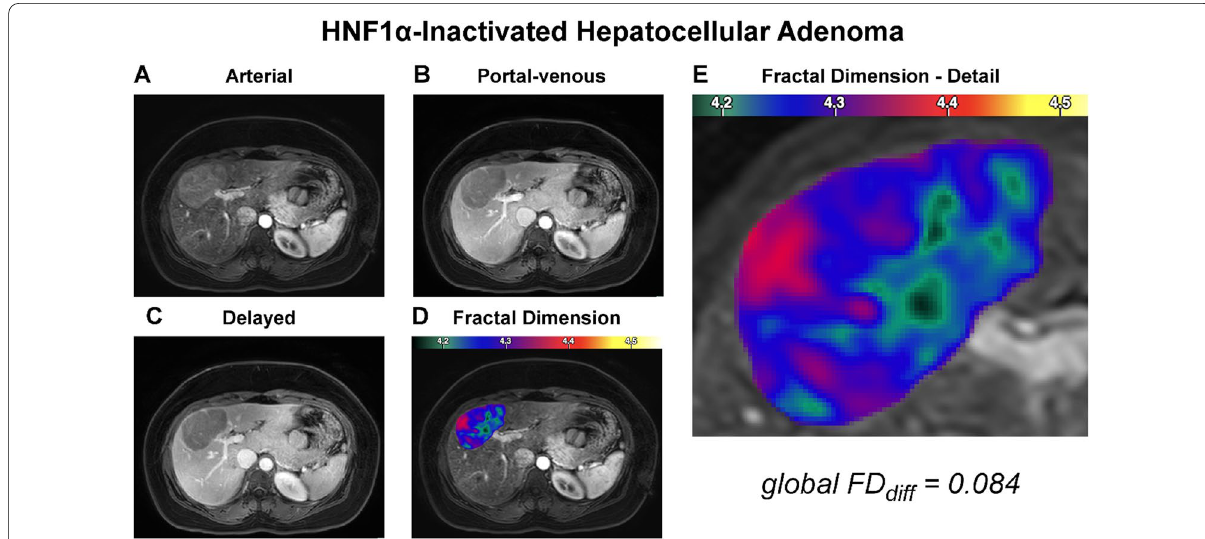
Fig. 2 Representative case of hepatocyte nuclear factor (HNF)-1α-inactivated hepatocellular adenoma. Dynamic contrast-enhanced MR images of the arterial ( A ), portal venous ( B ), and delayed ( C ) phase are shown along with the fractal dimension (FD) map as overlay over the arterial phase ( D ) and a zoom on the lesion ( E ). The panel organization is the same throughout Figs. 2, 3, 4, and 5. The depicted patient was a 26-year-old female with obesity (BMI 28 kg/m 2 ) and no history of oral contraception. She was admitted for characterization of an incidentally found liver mass. Typical MRI = features including arterial phase hyperenhancement, washout, and out-of-phase signal drop (not shown) suggested HNF1α-inactivated adenoma,